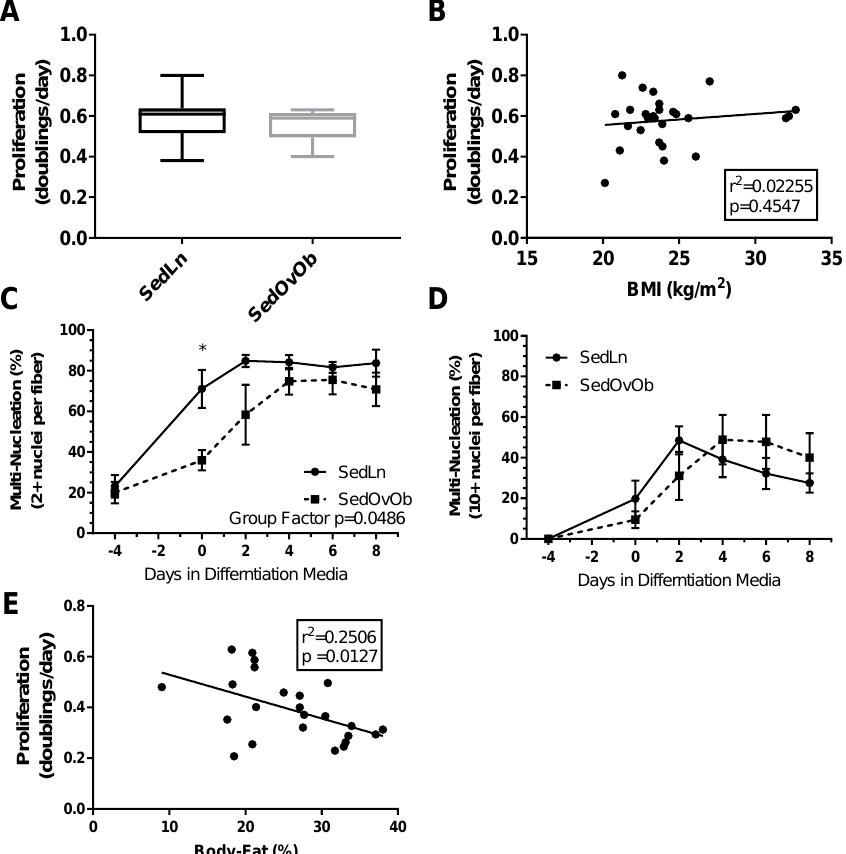
Figure 1. Proliferation rates (doubling/day) of satellite cells (SCs) isolated from sedentary lean (SedLn) ( n = 18, BMI 18 – 25 kg/m 2 ) and sedentary overweight/obese (SedOvOb) ( n = 5, BMI >25 kg/m 2 ) participants ( A ). Correlation of SC proliferation rate and donor BMI ( B ). Fusion index scores (( C ), 2+ nuclei per fiber, ( D ), 10+ nuclei per fiber) of SC from SedLn and SedOvOb donors. ( E ). Correlation of proliferation rate and donor bodyfat percentage (*, **, *** indicating a p -value of <0.05, <0.01, <0.001, respectively).